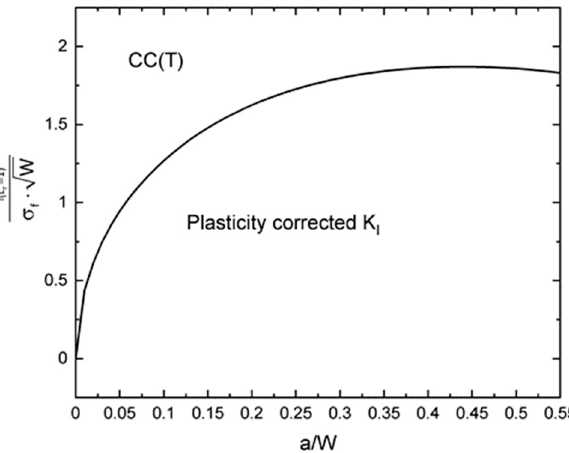
K I ( Lr = 1 ) ·√ for a CC(T) specimen, as a σ f W